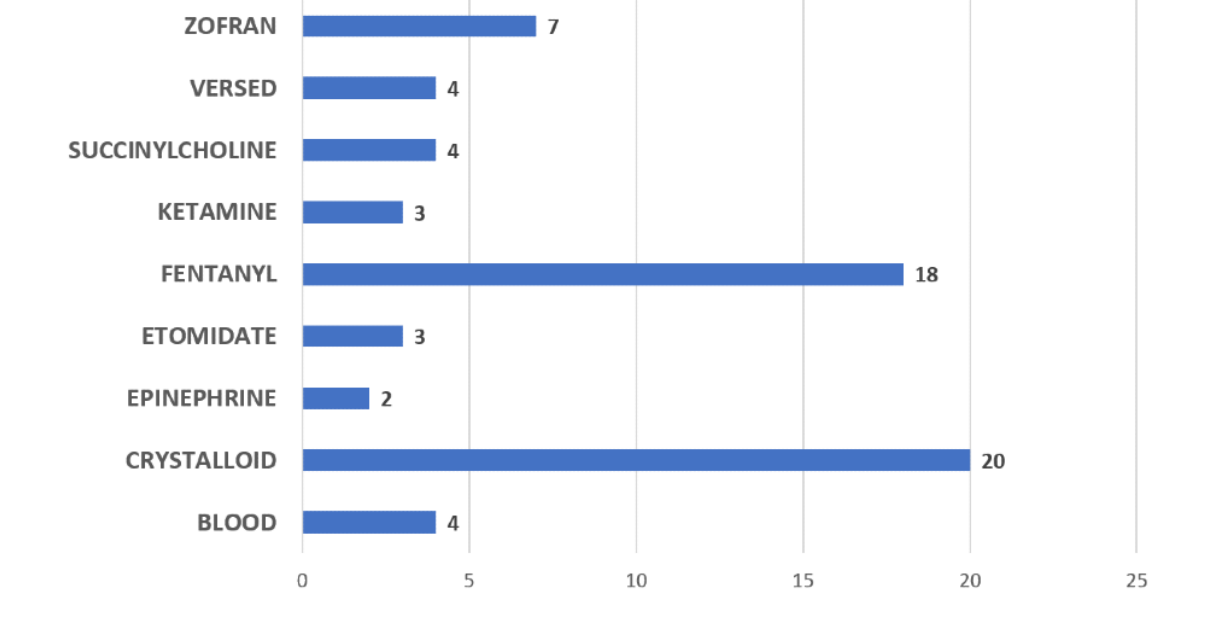
Figure 4. Medications and fluids administered during transport in the trauma videos.